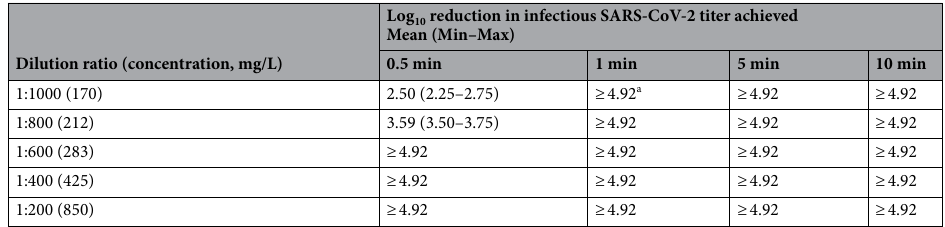
Table 4. Effect of Di-N-decyl dimethyl ammonium bromide (DNB) on SARS-CoV-2 inactivation. a The value of ≥ 4.92 means that no live virus is observed after the treatment, while the smaller values indicate that a different amount of virus survives after the treatment.